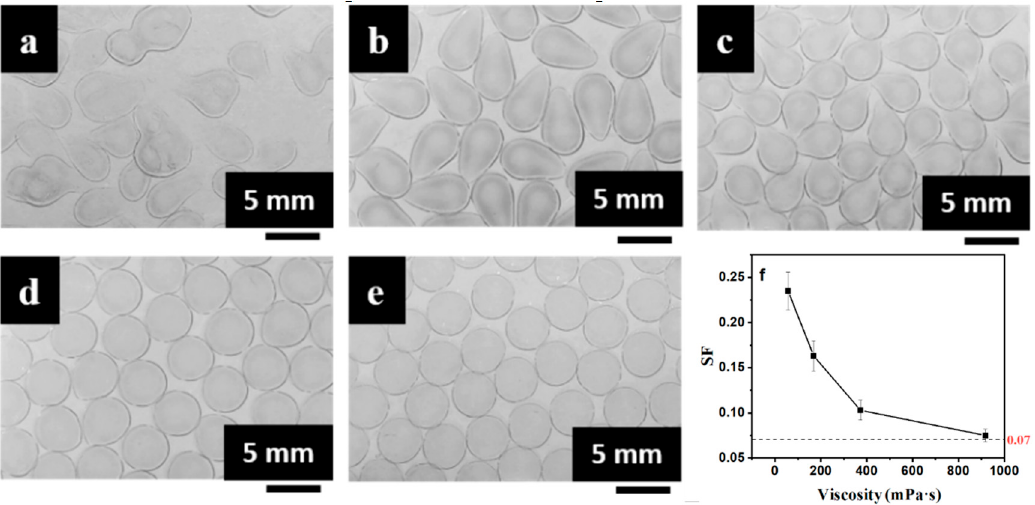
Figure 6. The e ff ect of CaCl 2 / CMC solution viscosity ( a ) 20.0 mPa · s, ( b ) 56.7 mPa · s, ( c ) 168.5 mPa · s, ( d ) Figure 6. The effect of CaCl 2 /CMC solution viscosity ( a ) 20.0 mPa·s, ( b ) 56.7 mPa·s, ( c ) 168.5 mPa·s, ( d ) 372.0 mPa · s and ( e ) 917.5 mPa · s on morphology and ( f ) SF of mm-CaSA-Caps when the viscosity of the 372.0 mPa·s and ( e ) 917.5 mPa·s on morphology and ( f ) SF of mm-CaSA-Caps when the viscosity of SA solution is 72.0 mPa · s. The concentrations of SA were 0.75 wt.%. The concentrations of CaCl 2 the SA solution is 72.0 mPa·s. The concentrations of SA were 0.75 wt.%. The concentrations of CaCl 2